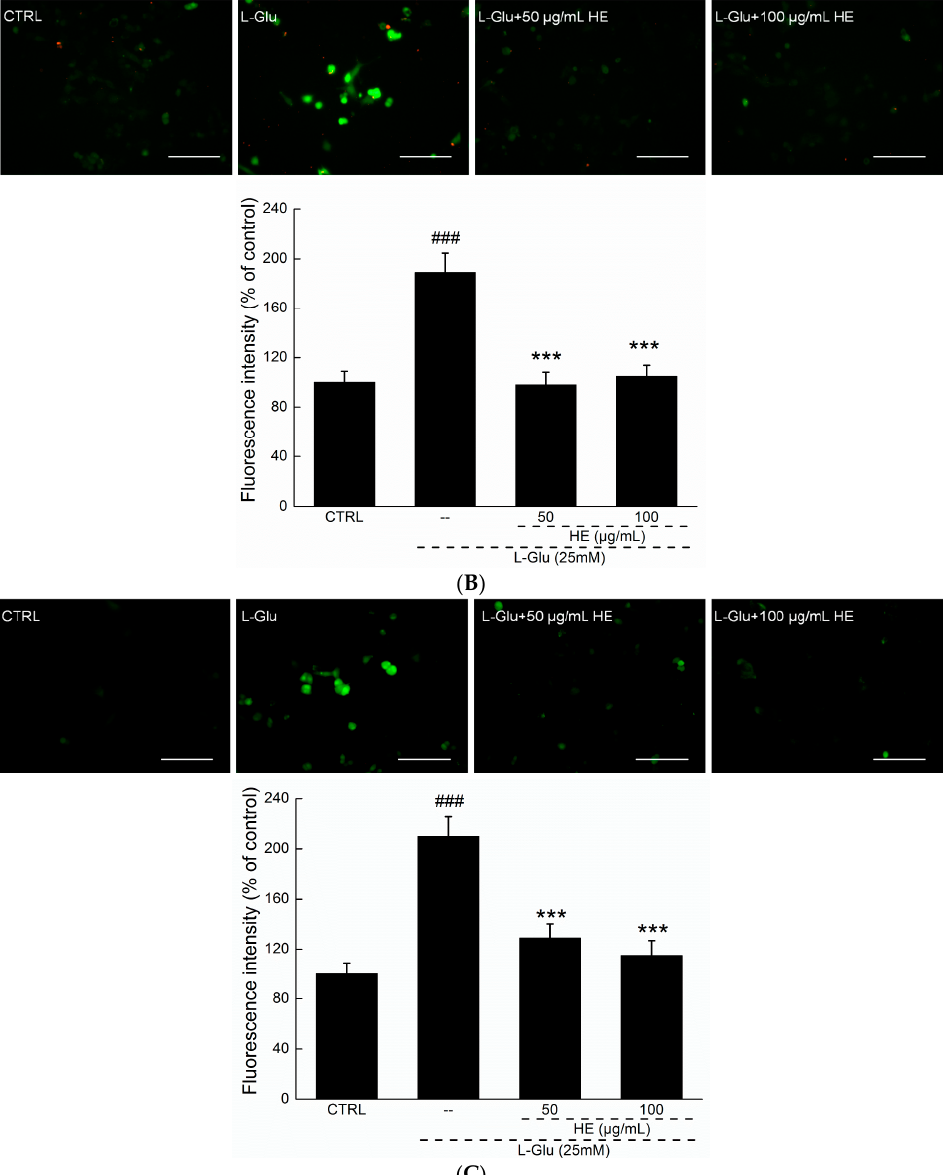
Figure 3. ( A ) The disruption of mitochondrial membrane potential (MMP) caused by 12 h L -Glu exposure was strongly restored by 3 h HE pretreatment analyzed via JC-1 staining ( n = 6). Scale bar: